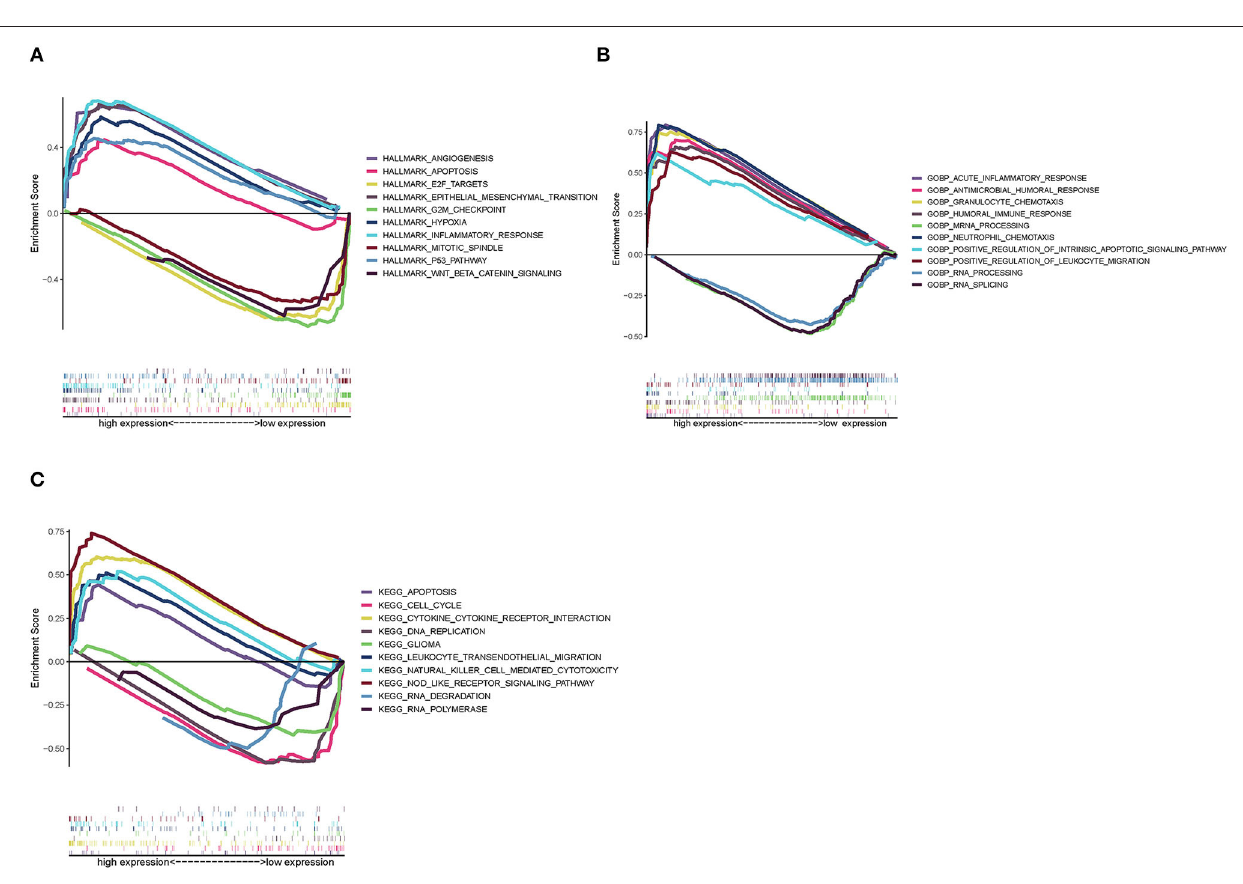
FIGURE 9 | GSEA enrichment analysis for samples with high expression and low expression of SAA1. (A) GSEA results in a Hallmark collection. (B) GSEA results in GO collection. (C) GSEA results in KEGG collection. and that for LAIR1 and TNFSF14 was 1%, which